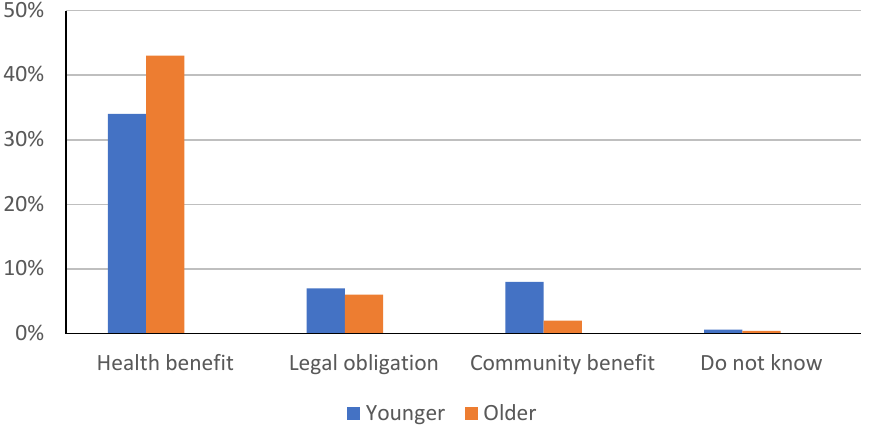
Figure 1. A comparison of the reasons for vaccinating children between the groups of respondents. Most of the participants from both groups decided to vaccinate their children for the benefit of the children’s health, 75.85% of them ( n = 223), while 12.93% ( n = 38) of the respondents opted for vaccination due to the legal obligation. It was observed that the older group preferred children’s health benefits as a reason for vaccination for 9.19% more than the younger group. On contrary, 6.12% more of younger respondents decided to vaccinate their children for the benefit to the community.